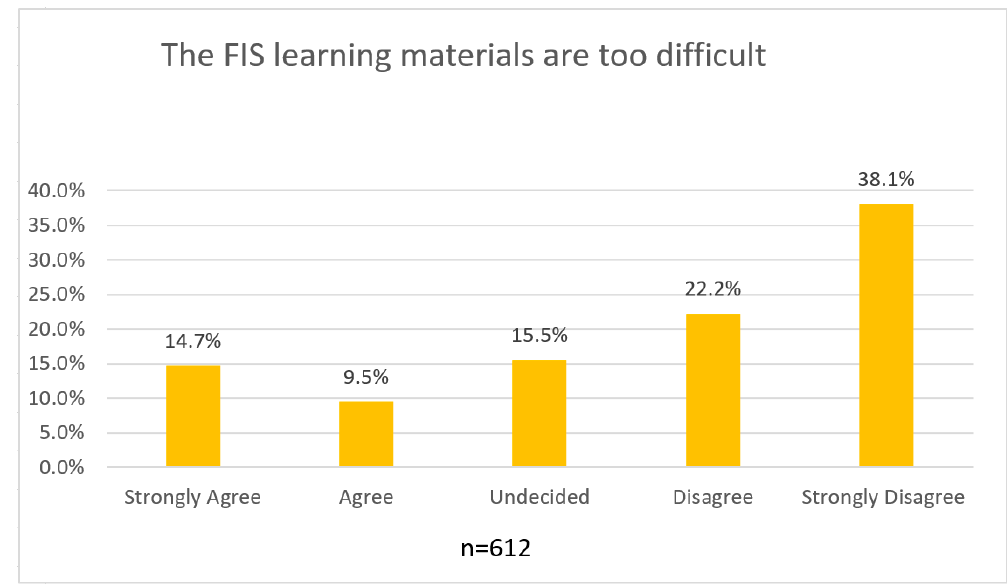
Figure 5. Pupils agreement with the statement: “The FIS learning materials are too difficult”.